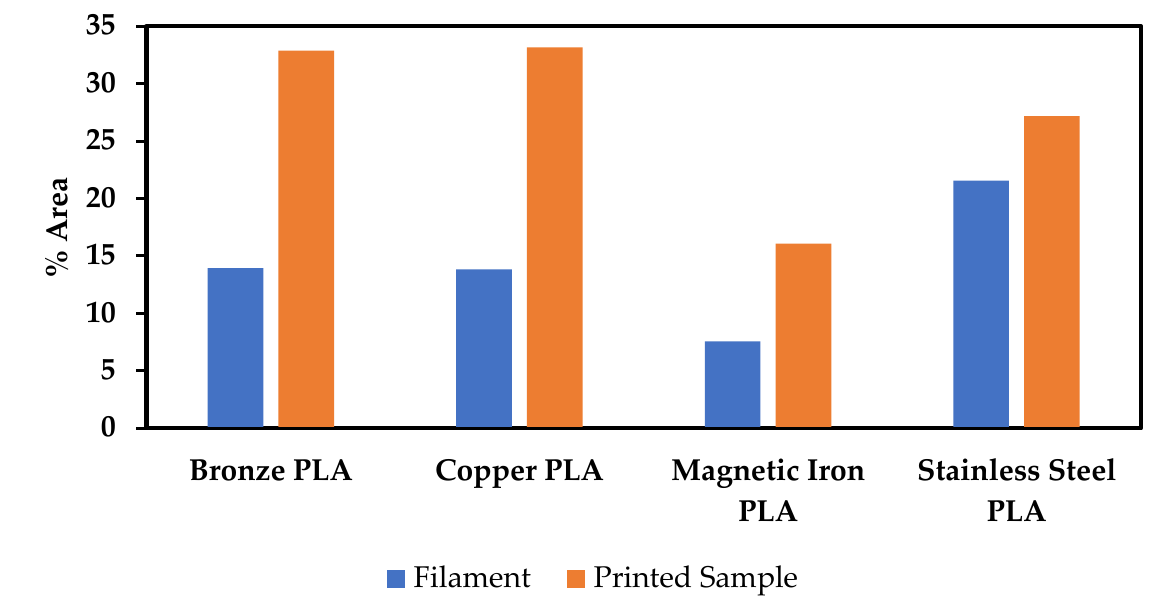
Figure 7. The measured area percent of Br-PLA, Cu-PLA, MI-PLA, and SS-PLA before and after printing. Table 2. The measured area percent of Bronze (Br), Copper (Cu), Magnetic Iron (MI), and Stainless Steel (SS) in reinforced PLA filament and printed samples.